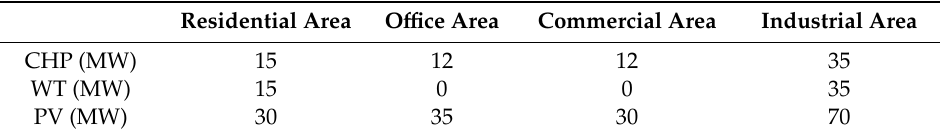
Table A1. Power capacities of multiple functional areas.